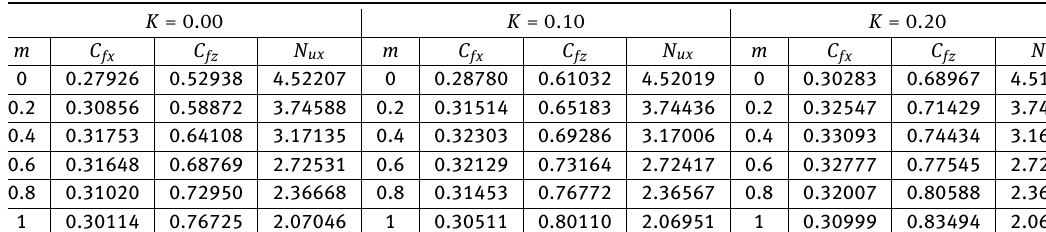
Table 2: Results for increasing K as the surface becomes a flat horizontal surface K = 0.00